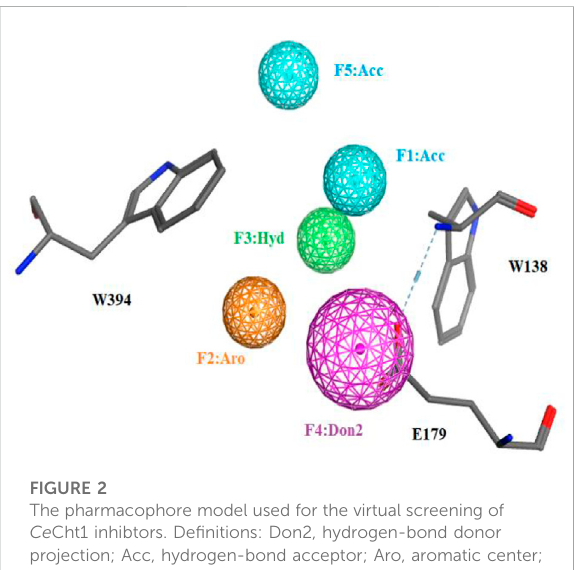
FIGURE 2 The pharmacophore model used for the virtual screening of Ce Cht1 inhibtors. De fi nitions: Don2, hydrogen-bond donor projection; Acc, hydrogen-bond acceptor; Aro, aromatic center; Hyd, hydrophobic